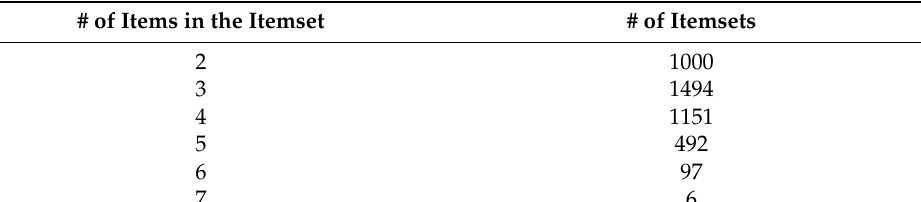
Table 8. Distribution of itemsets for Interpretation 1 applied to the large data set.